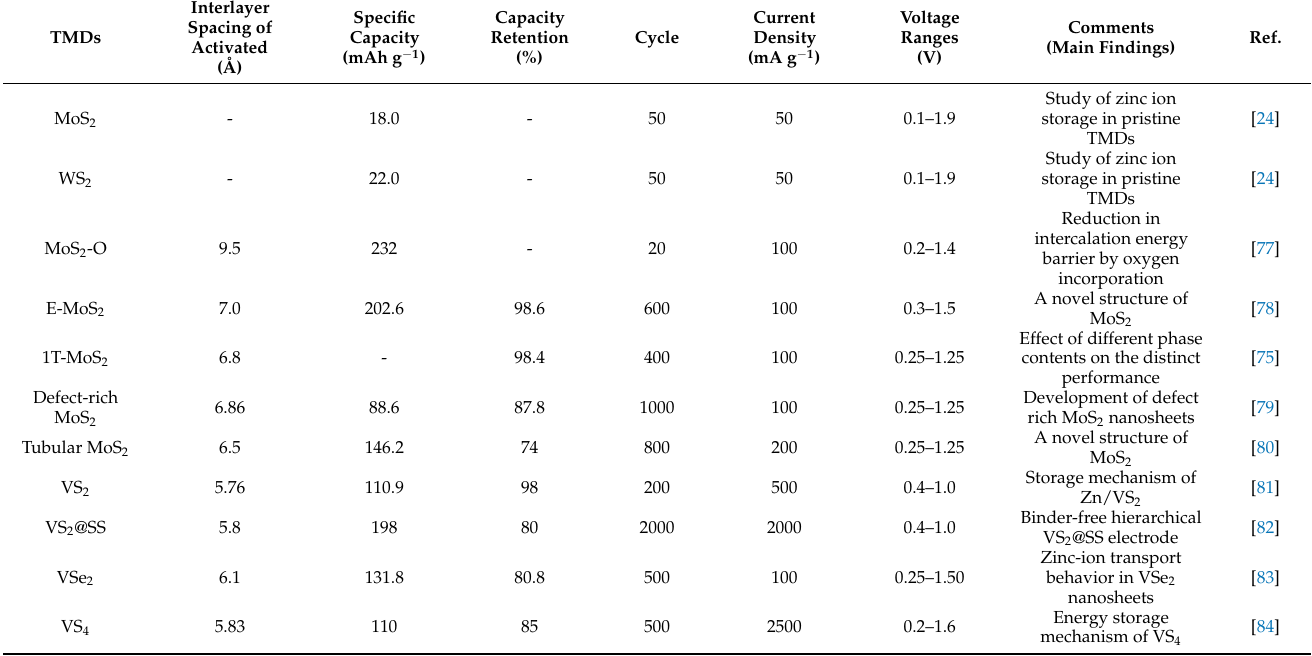
Table 2. Electrochemical performance of TMDs as zinc-ion batteries (ZIB)